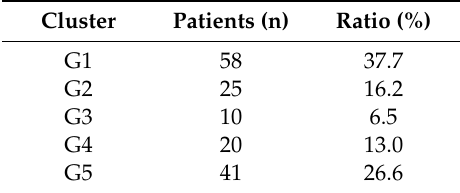
Table 2. Proportion of patients following unsupervised clustering with normalized enrichment